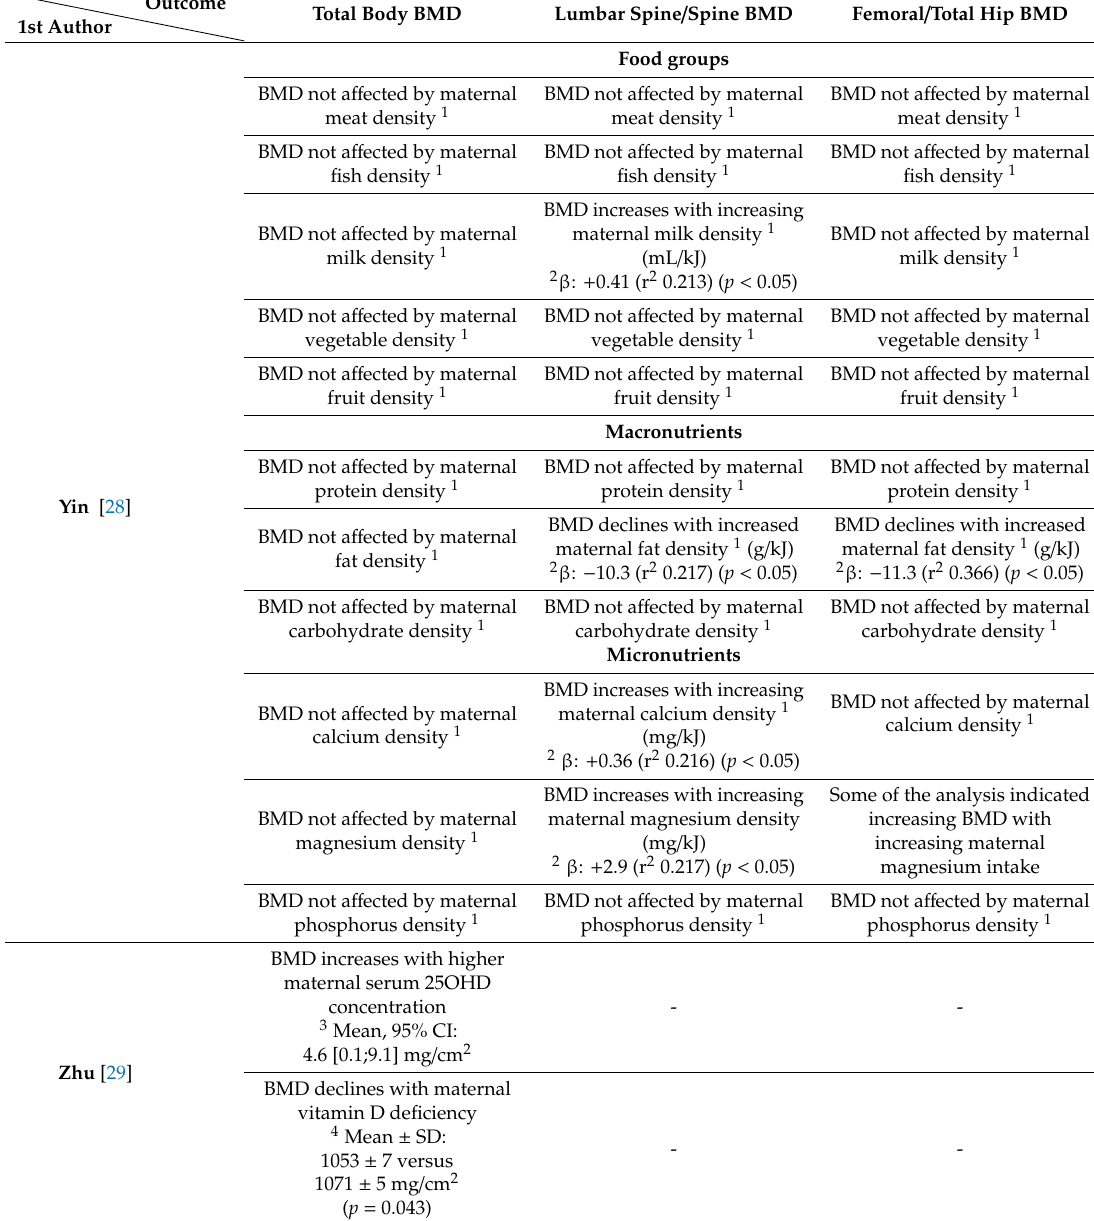
Table 3. Summary table of results from the articles evaluating the association between the o ff spring bone mineral density, maternal nutrient intake, and vitamin D status during